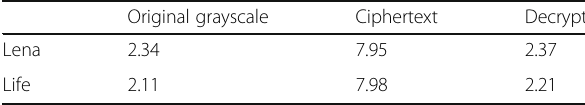
Table 1 Entropy value comparison table before and after